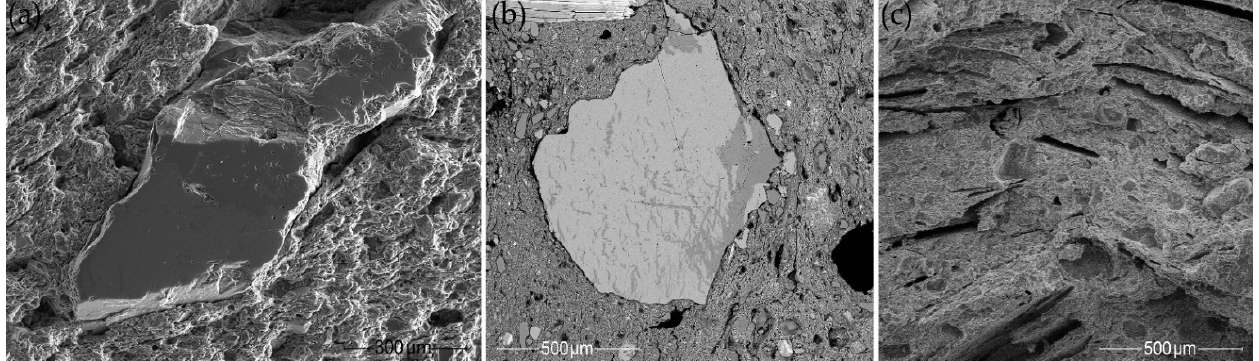
Figure 19. Late fine pottery: ( a ) CW-L_M4, SEM SE image of the sponge-textured clay matrix with alkali feldspar inclusion; ( b ) CW-L_M4, SEM BSE image of the quartz-rich clay matrix with alkali feldspar inclusion; ( c ) HG-L_B1, SEM SE image of the clay matrix with voids of